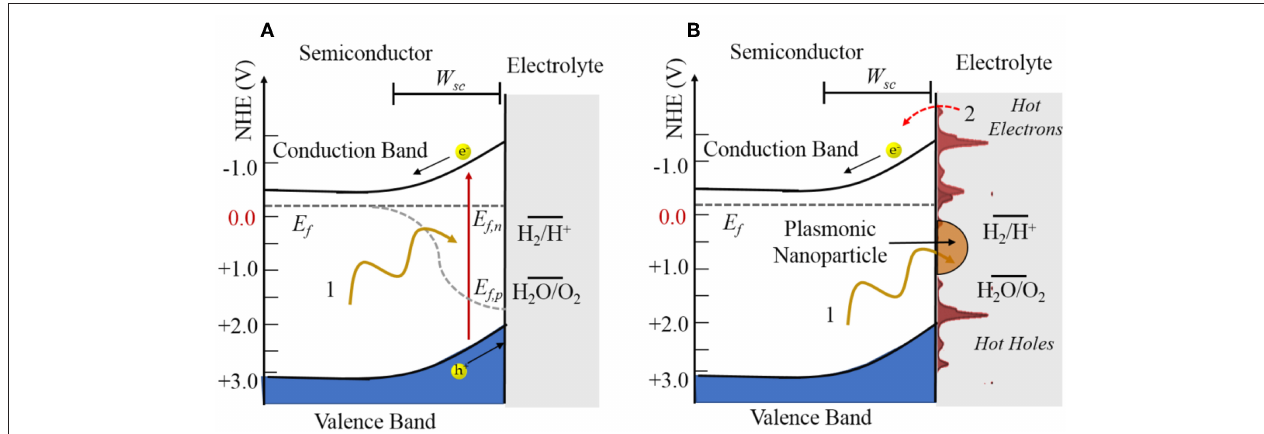
FIGURE 3 | Illustration of (A) an n -type semiconductor-electrolyte interface under irradiation and (B) an n -type semiconductor with a plasmonic nanoparticle attached at the surface. The quasi-Fermi levels in (A) are labeled by E f , n and E f , p and the Fermi level in (B) labeled by E f . The space charge width is labeled by W sc .